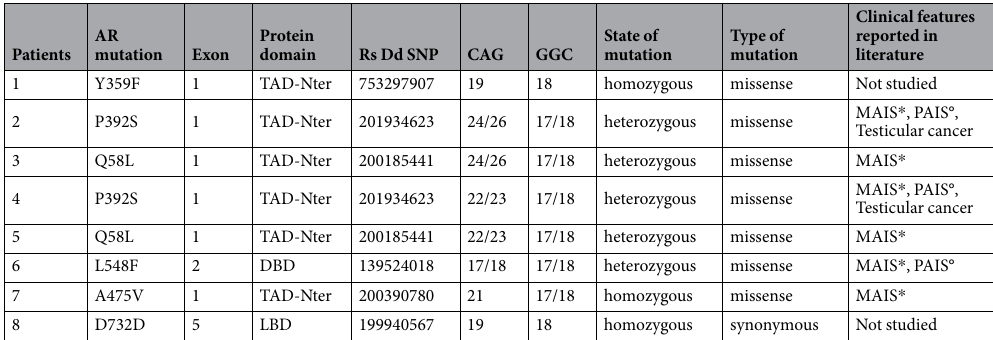
Table 2. AR variation found in our patients: type of mutation, exon and domain involved, acronym that identifies the variation (rS), number of CAG and GGC repetition, number of allele mutated, corresponding phenotype when available.